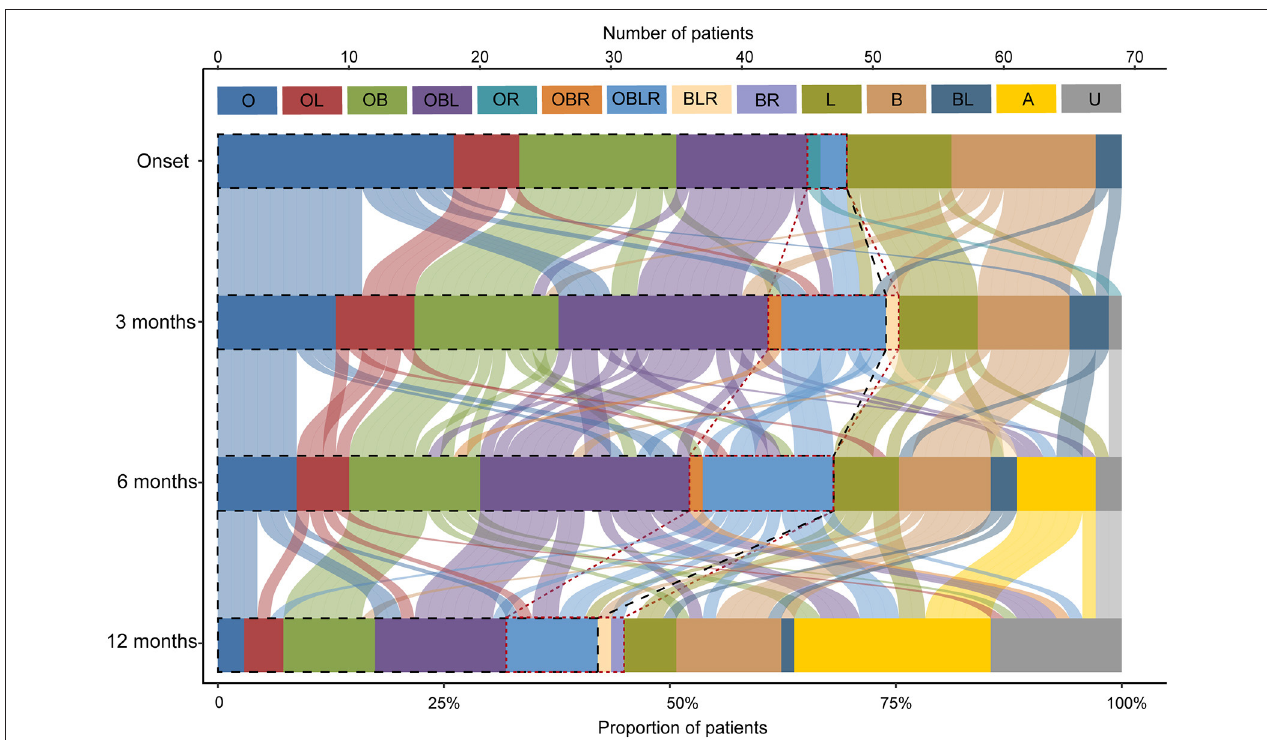
FIGURE 3 | Point-in-time weakness distribution and shifts over time. The point-in-time weakness distribution at disease onset and 3, 6, 12months after onset. O, extraocular muscles; B, bulbar muscles; L, limb or neck muscles; R, respiratory muscles; and their multiple combinations. A, asymptomatic; U, unknown, patients who were lost to follow-up at this time point. The black dotted line outlined the patients with ocular involvement and the red dotted line outlined the patients with respiratory